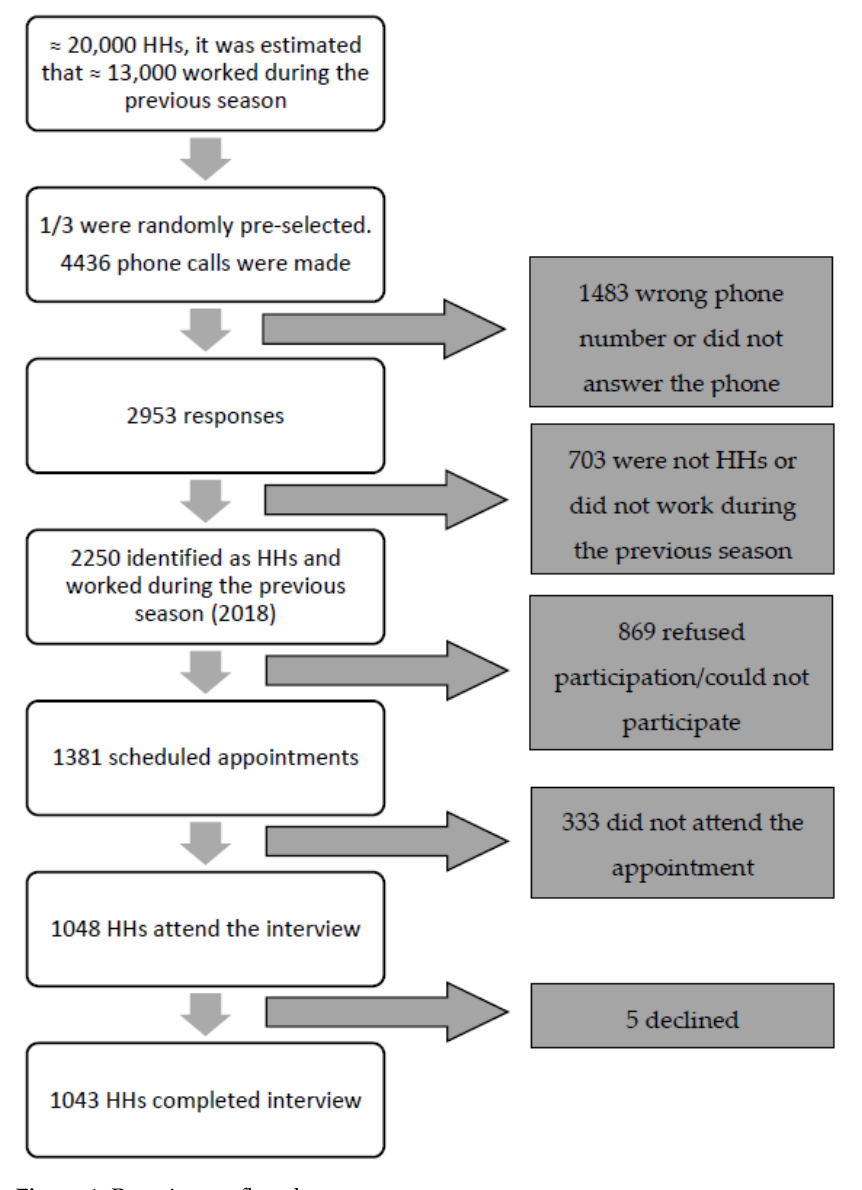
Figure 1. Recruitment flowchart.